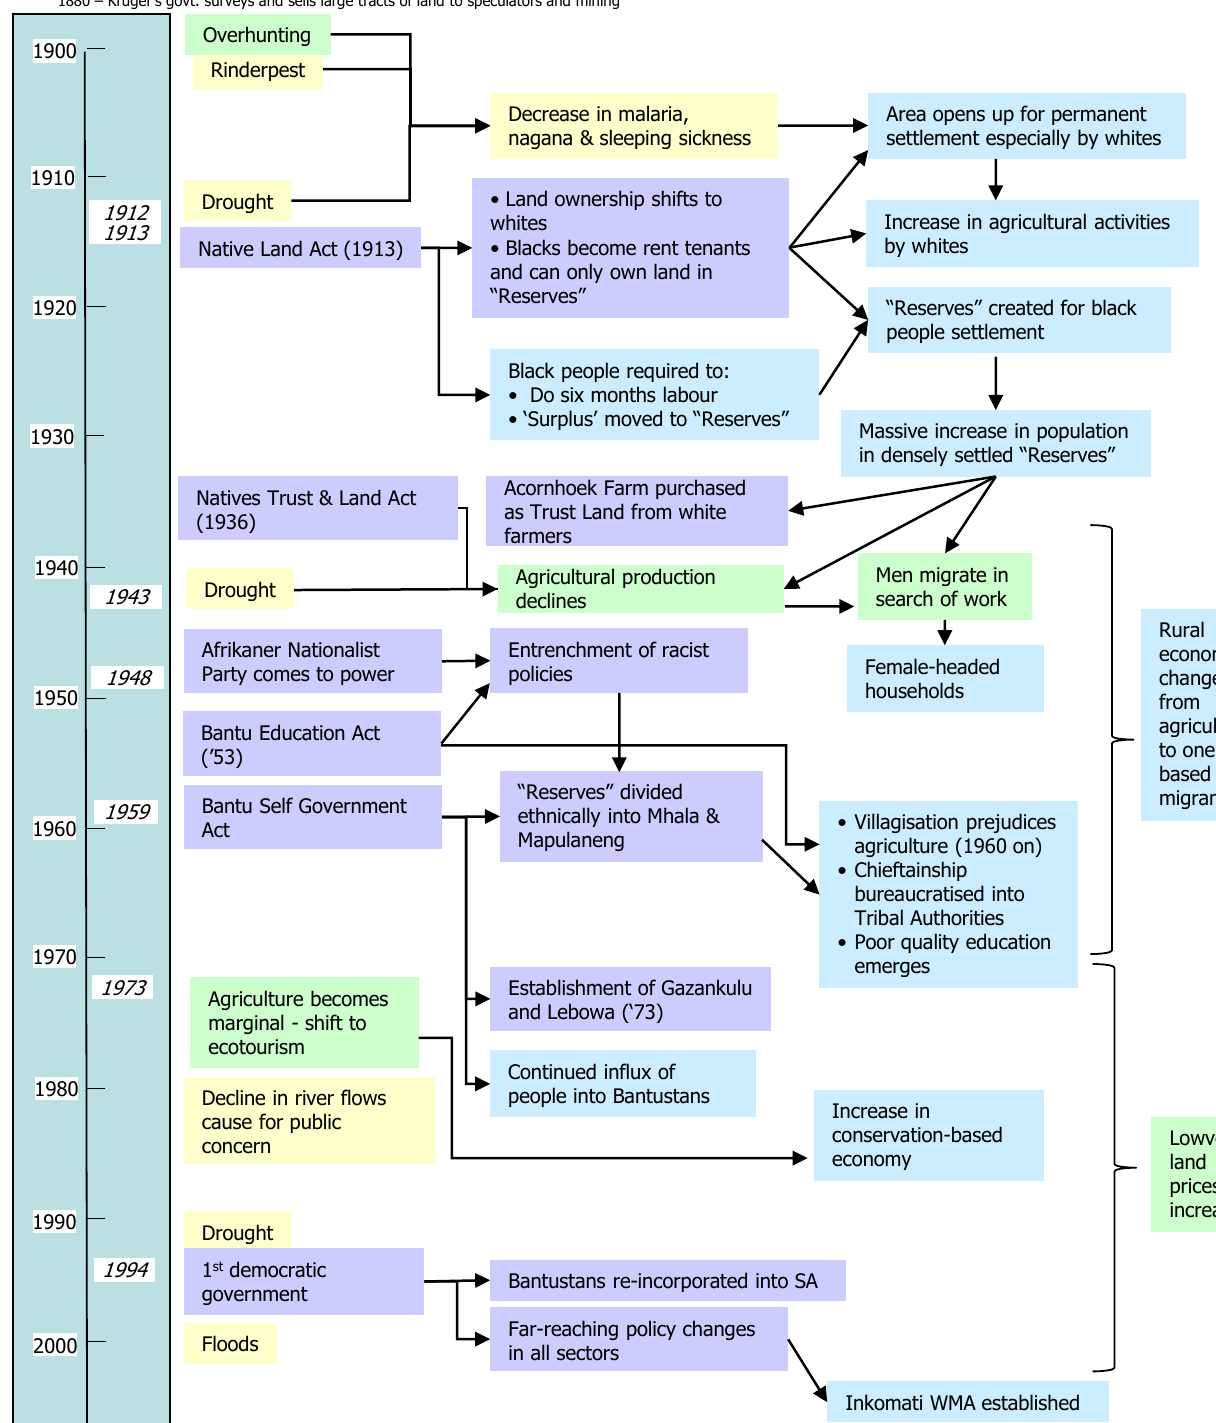
Figure A 1.1. Timeline developed for Zone B of the Sand River Catchment showing key events and outcomes. Primary drivers are grouped into political, economic and environmental categories (purple, green and yellow respectively). Major outcomes are shown in blue. Evidence for this is given in chapters 3 and 4 of Pollard et al. (2008), and in contextual scoping (see Appendix 3). Note that these interpretations are those of the authors and reviewed by the specialist group (see text). Similar timelines were also drawn for Zones A and C. WMA = Water Management